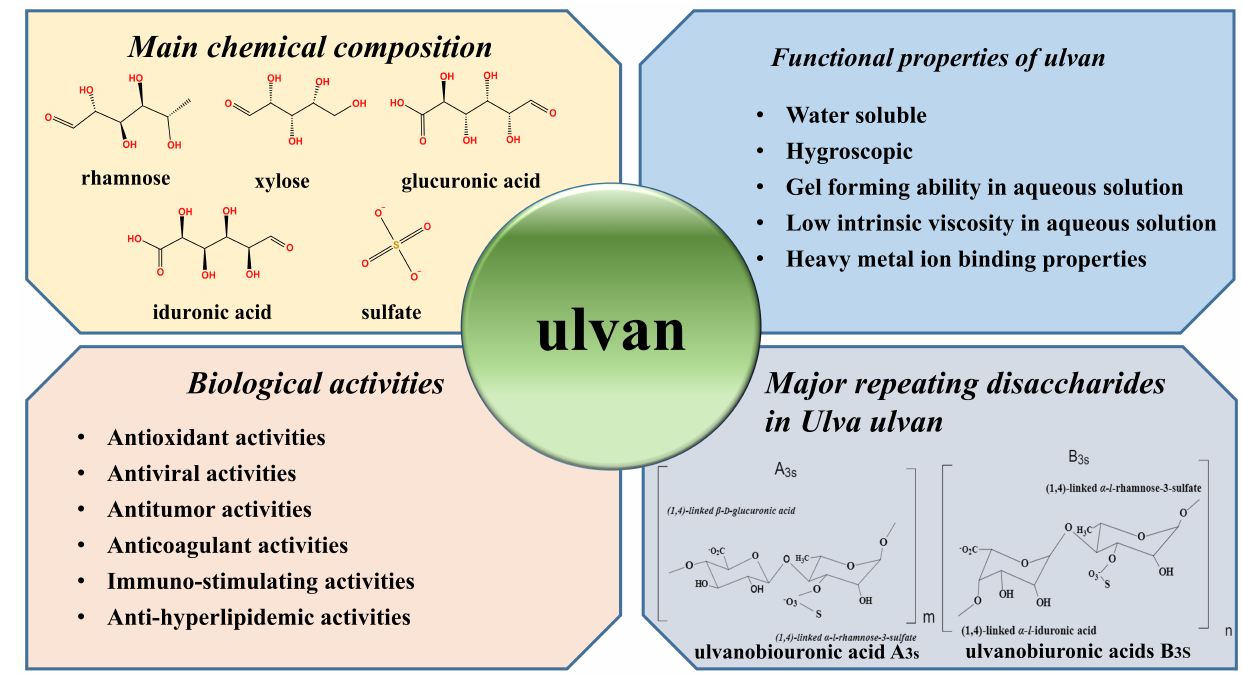
Figure 1. Structural and physiochemical Figure 1